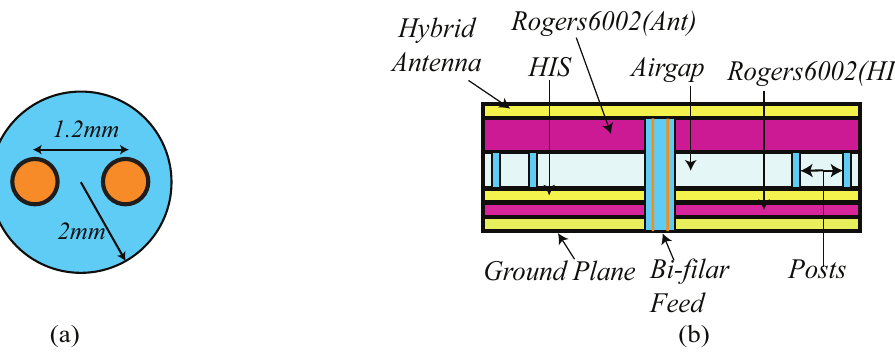
Figure 7. Bi-filar feeding ( a ) top view ( b ) Cross section view with antenna (not to